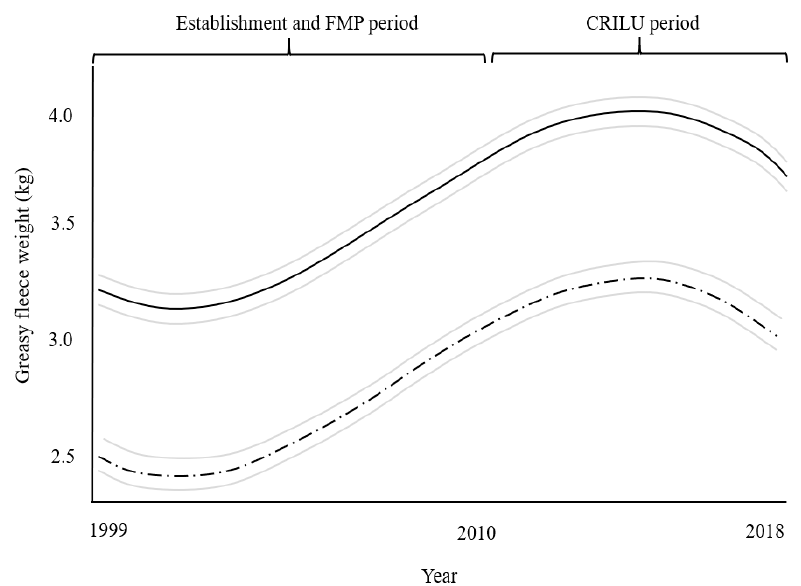
. Figure 2. Male (solid line) and female (non-solid line) phenotype trends using a third-degree Figure 2. Male (solid line) and female (non-solid line) phenotype trends using a third-degree poly- polynomial regression model for greasy fleece weight at shearing (298 to 432 days of age) across the nomial regression model for greasy fleece weight at shearing (298 to 432 days of age) across the entire study period (1999–2018). The light gray lines represent the 95% confidence limits. R 2 for the entire study period (1999–2018). The light gray lines represent the 95% confidence limits. R 2 for the combined (male and female), male and female models were 0.61, 0.55 and 0.54, respectively. combined (male and female), male and female models were 0.61, 0.55 and 0.54, respectively. . Across the entire study period, for the combined male and female data, 69% (R 2 ) of the phenotypic changes in one-year-old lamb LW post-shearing was explained by the Figure 2. Male (solid line) and female (non-solid line) phenotype trends using a third-degree poly- third-degree polynomial regression model. The R 2 for males and females was 0.23 and nomial regression model for greasy fleece weight at shearing (298 to 432 days of age) across the entire study period (1999–2018). The light gray lines represent the 95% confidence limits. R 2 for the 0.25, respectively. In both sexes, LW post-shearing at the end of the study period (2018) combined (male and female), male and female models were 0.61, 0.55 and 0.54, respectively. was heavier than the starting year (1999, Figure 3).